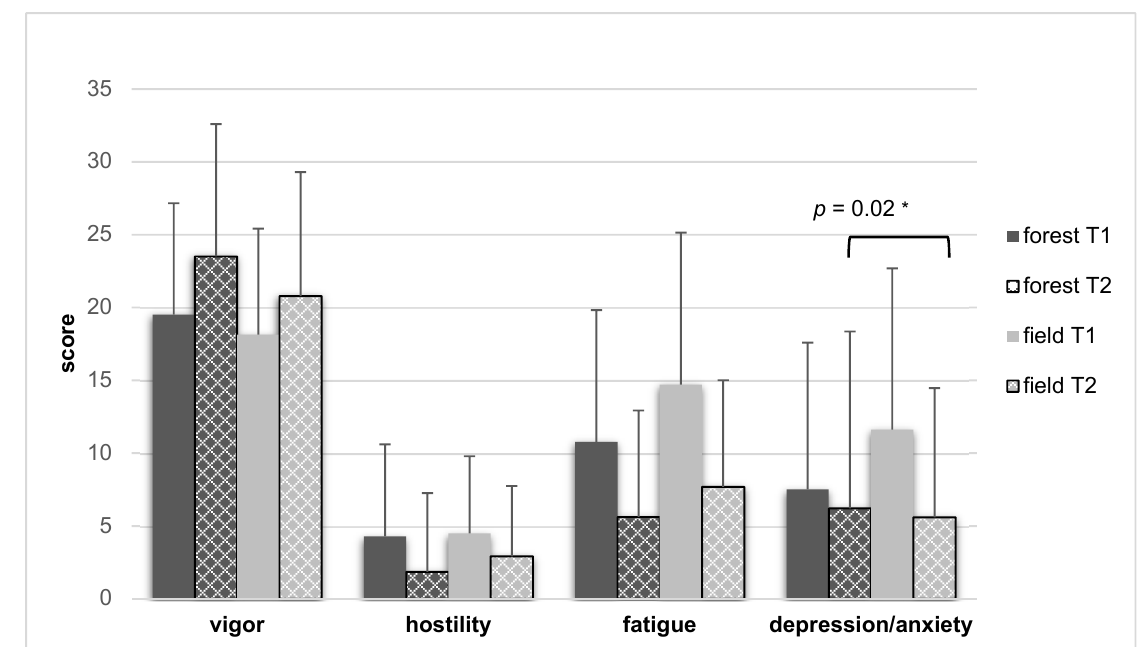
Figure 5. ITT analysis of the POMS ( n = 39, mean values ± standard deviation), and comparison of forest and field interventions. Higher values show improvement in vigor; lower values show improvement in hostility, fatigue, depression/anxiety. T1 = before, T2 = after intervention, p = significance level of the difference T2-T1, * p < 0.05.